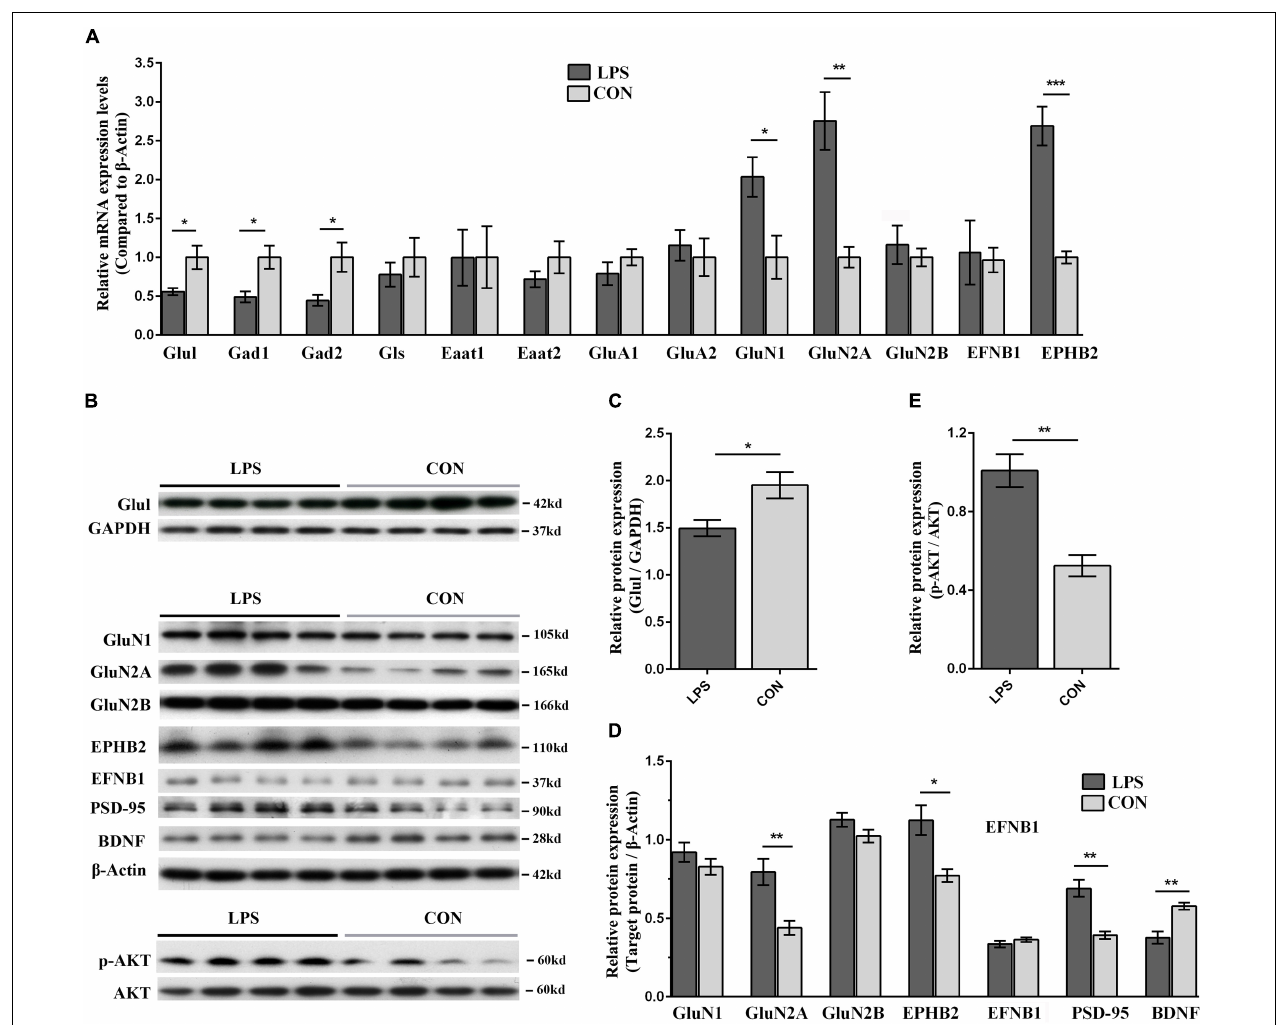
FIGURE 7 | Validation of key players in Ephrin receptor signaling and glutamatergic transmission in the hypothalamus of LPS-induced depressed mice in both the mRNA and protein levels. (A) Transcriptional profiling of glutamatergic transmission-related proteins and Ephrin receptor signaling-related proteins. The mRNA changes were detected by qRT-PCR. All samples were normalized to the β -Actin gene as a control. The fold increase or decrease was relative to the CON group as the reference. (B) Immunoblotting validation of centering on EPHB2-NMDAR-AKT cascade related key proteins. The abundance of Glul, GluN1, GluN2A, GluN2B, EPHB2, EFNB1, PSD-95, BDNF, p-AKT, and AKT was determined using their corresponding specific antibodies. Equal amounts of protein fractions were loaded. (C–E) The expression of Glul (C) , GluN1, GluN2A, GluN2B, EPHB2, EFNB1, PSD-95, BDNF (D) , p-AKT, and AKT (E) was quantified according to the corresponding bands of proteins in (B) . GAPDH and β -Actin protein were used as the internal reference marker and loading control for normalization, respectively. All samples were validated in triplicate. The bands for the same proteins were analyzed by densitometry using Quality One software (version 4.6.6). Student’s t -test was utilized to analyze the significant difference between two groups. Values are presented as the means ± SEM ( n = 5/group in qRT-PCR test, n = 4/group in WB test). ∗ P < 0.05, ∗∗ P < 0.01, ∗∗∗ P < 0.001, LPS vs.